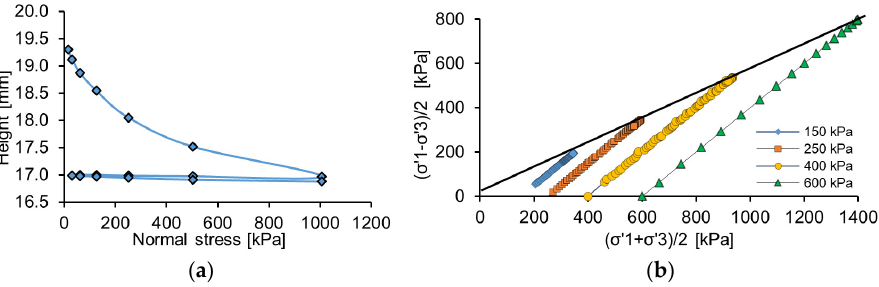
Figure 7. Laboratory test results ( a ) oedometric test—sample no. 1; ( b ) TXCID results on the p - q plane.